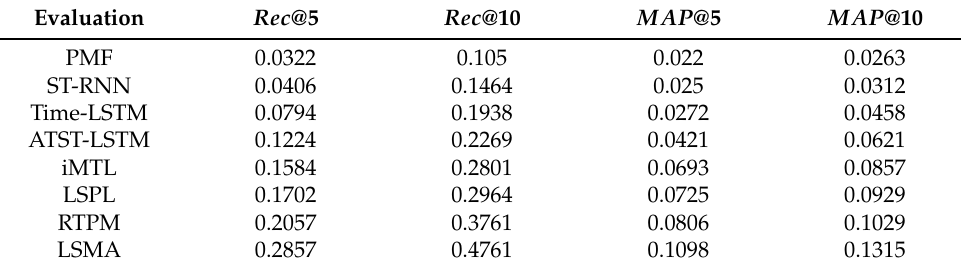
Table 2. The recommendation result of different methods for the NYC